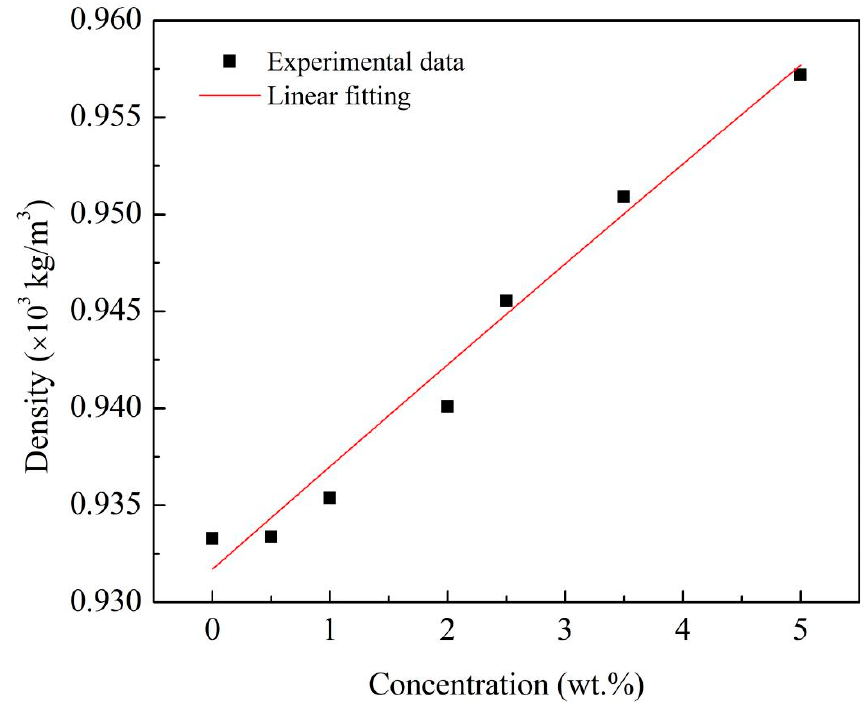
Figure 5. Density of Al/JP-10/oleic acid nanofluid fuels at different Al concentrations. At different concentrations, the viscosity of the Al/JP-10/oleic acid nanofluid fuels was repeatedly measured and the results are shown in Figure 6. When the mass fraction of the Al nanoparticles was 0.5 wt.%, the viscosity of the nanofluid fuel approximated that of the base fuel. At Al concentrations of 0.5~5.0 wt.%, the viscosity of the nanofluid fuels increased significantly. The viscosity is a quadratic function of Al concentration, which can be expressed as: where µ nf and µ bf are the viscosity of the nanofluid fuel and base fuel, respectively. The viscosity responds to the volume stress system of the nanofluid fuels and the coupled or interactive stable thermodynamic forces between nanoparticles. Chen et al. [24] explained that the thermodynamic force not only directly affects the volume stress, but indirectly affects the volume stress by changing the relative position of the nanoparticles. The direct and indirect contributions to the volume stress relate to the first-order ( ϕ ) and second-order ( ϕ 2 ) terms in Equation (3), respectively. Multiple measurements of the surface tension of the nanofluid fuels are shown in Figure 7. It is noticed that the surface tension of the nanofluid fuels with Al concentrations of 0.5~5.0 wt.% is lower than that of the base fuel, suggesting that the Al nanoparticles tend to accumulate on the liquid/gas interface and decrease the surface tension [25,26]. For the nanofluid fuels, with increasing Al concentrations, the surface tension oscillated, following the